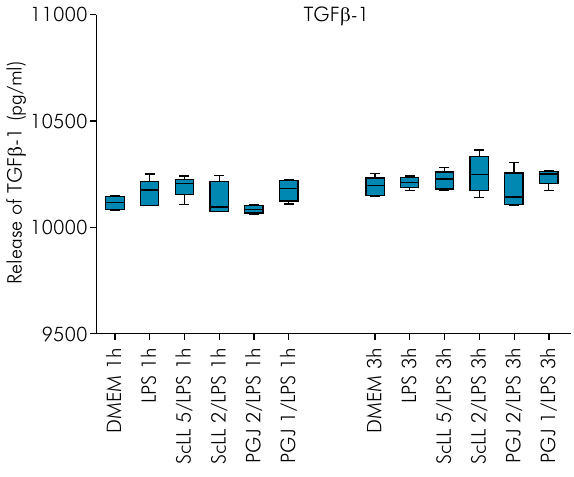
Figure 3. Release of TGF β -1 in HGFs examined by Elisa at 1 and 3 h. Statistical significance was determined using one-way ANOVA and Dunnett’s